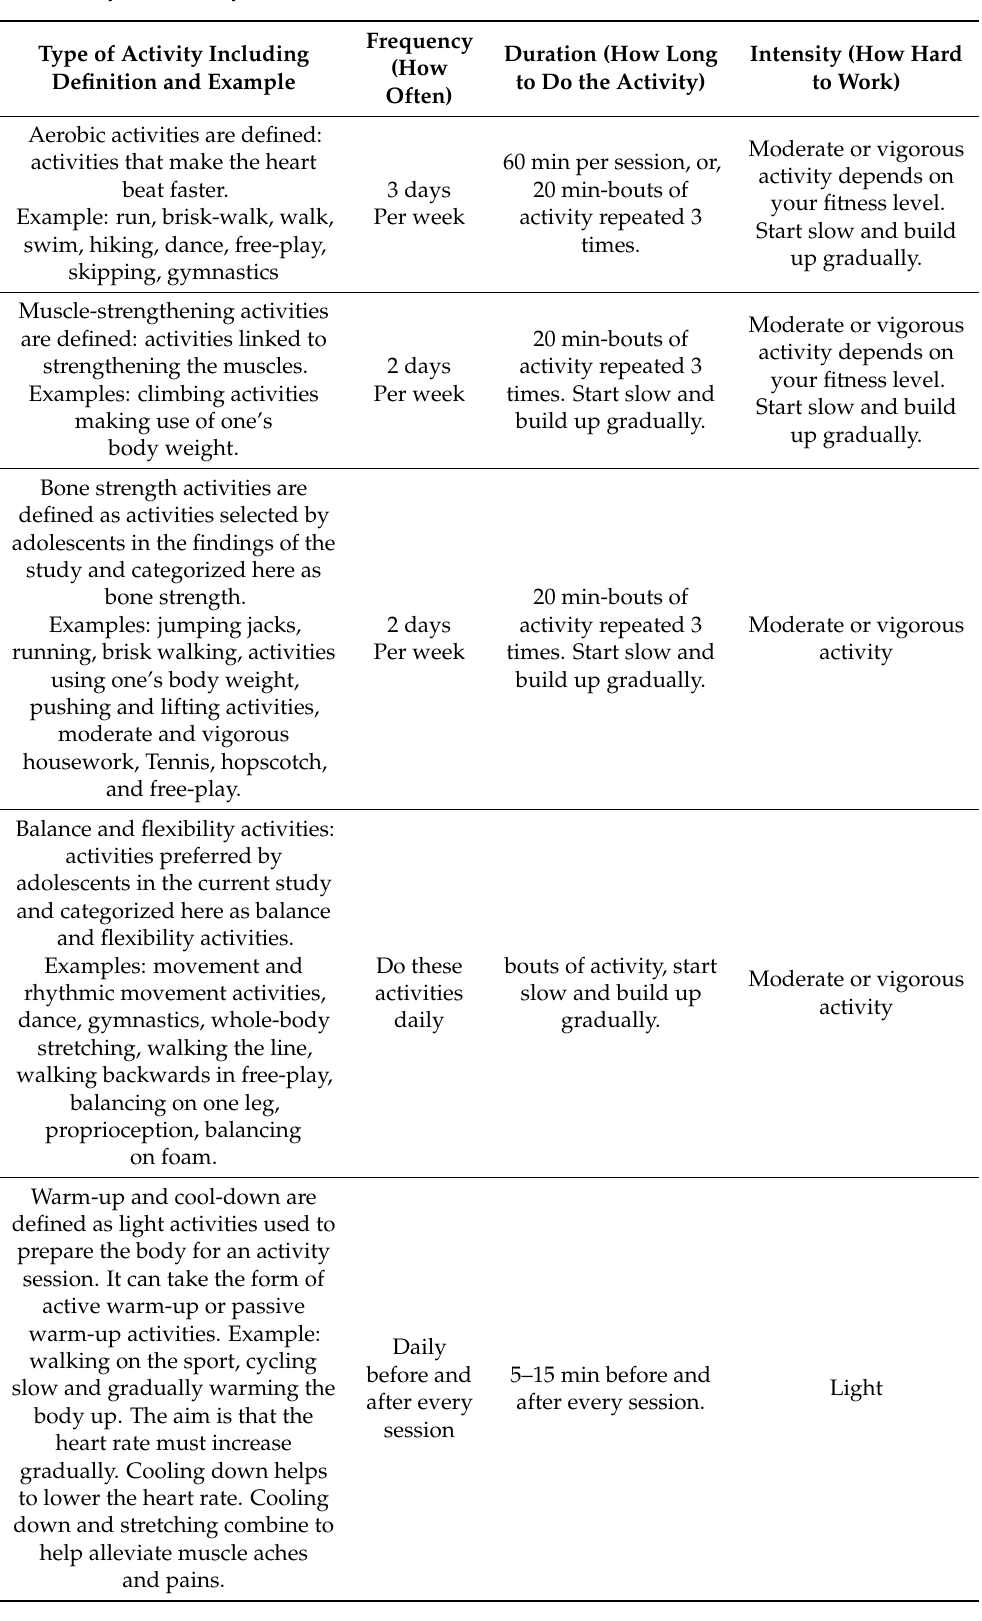
Table 2. Physical activity